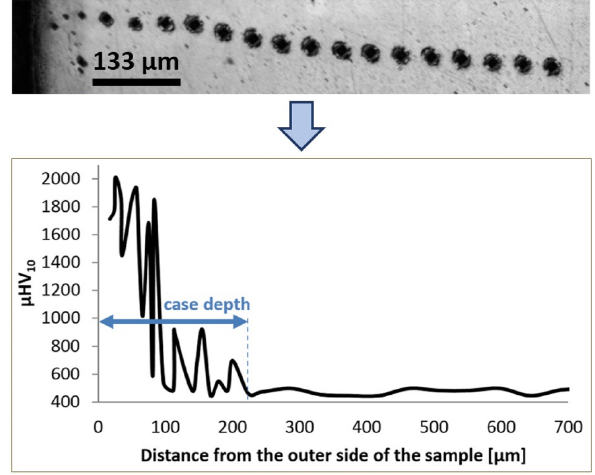
Figure 3: Example of the case depth measurement – plasma- nitrided martensitic stainless steel. As it can be seen, the case depth is observed up to ca. 220 µ m from the outer side of the sam-